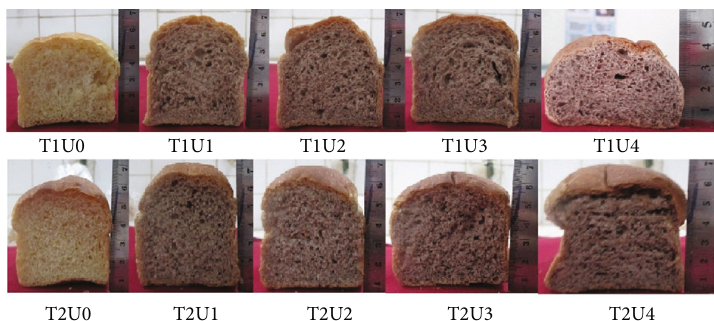
Figure 5: Appearance of bread with di ff erent baking temperature and yam fl our addition. Note: T1: baking temperature 170 ° C; T2: baking temperature 180 ° C; U0: yam fl our 0%; U1: yam fl our 10%; U2: yam fl our 15%; U3: yam fl our 20%; U4: yam fl our